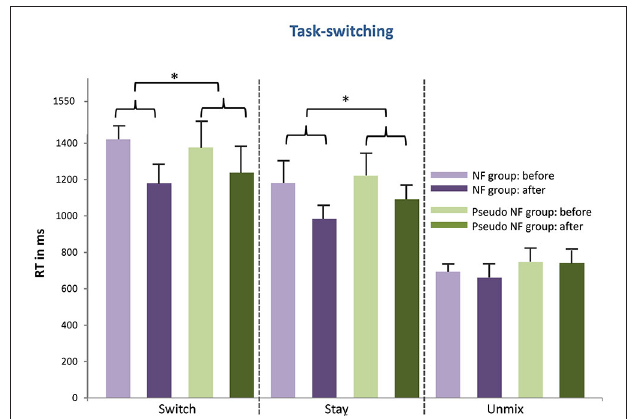
FIGURE 4 | Shows the behavioral results of the task-switching (mean RT and standard error of mean) for the NF group (left) and the pseudo-NF group (right) for all three conditions (unmix, stay, switch) before and after the training intervention . Significant differences (pre-post differences as depicted with curly brackets) are marked with stars and are depicted between both groups as training results. Stronger enhanced RTs can be observed for the NF group in the stay and switch condition.